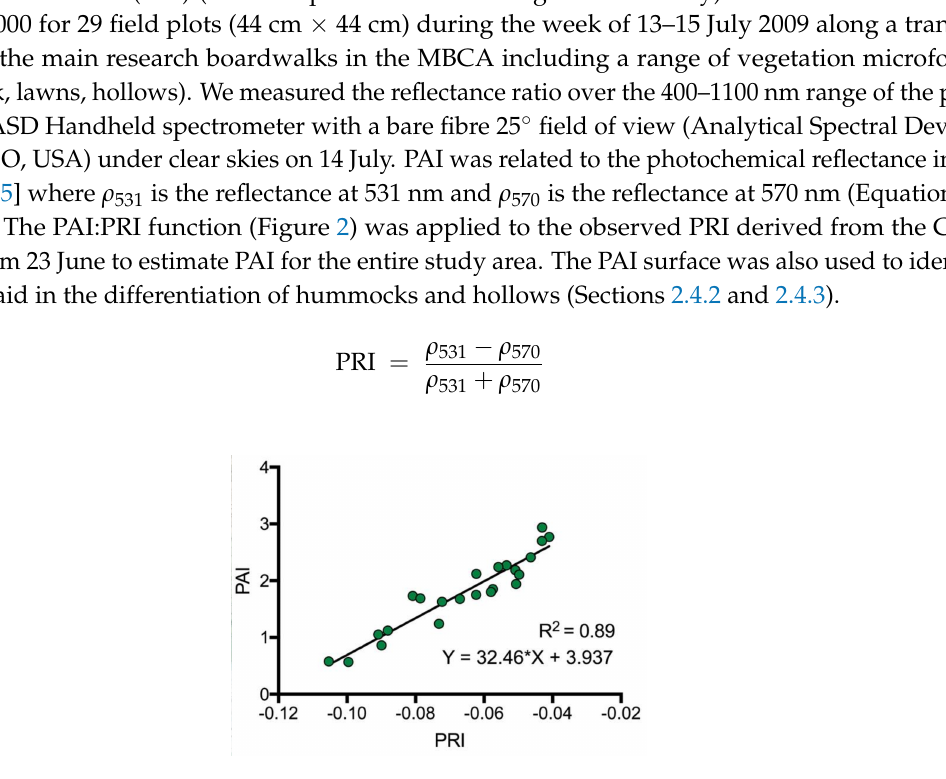
Figure 2. Relationship between the photochemical reflectance index (PRI) and plant area index (PAI) ( p <